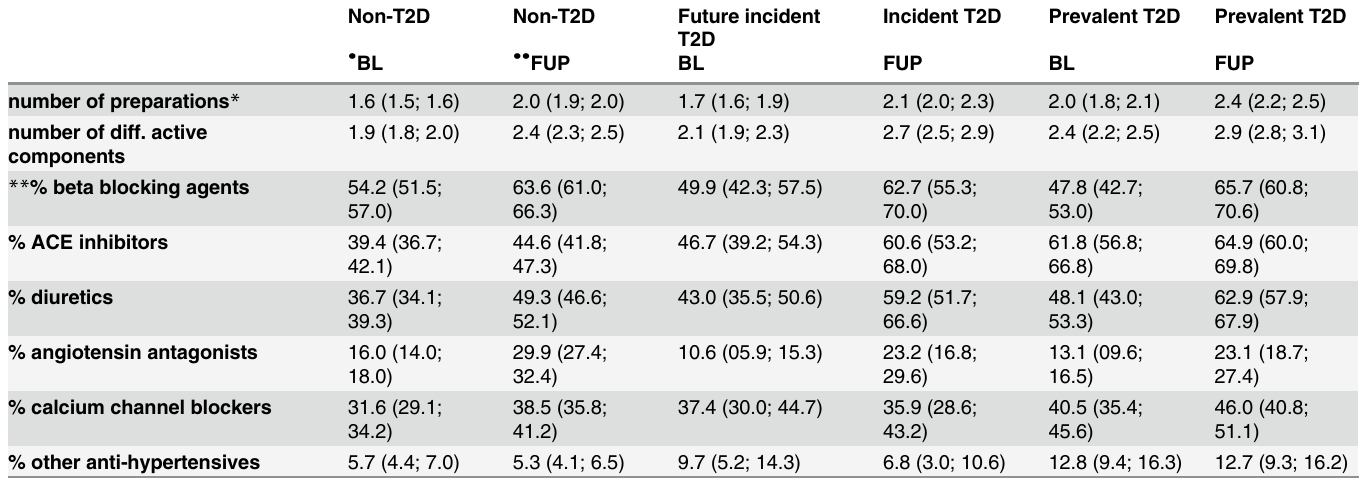
Table 5. Numbers of preparations and active agents and percentages of anti-hypertensive medications